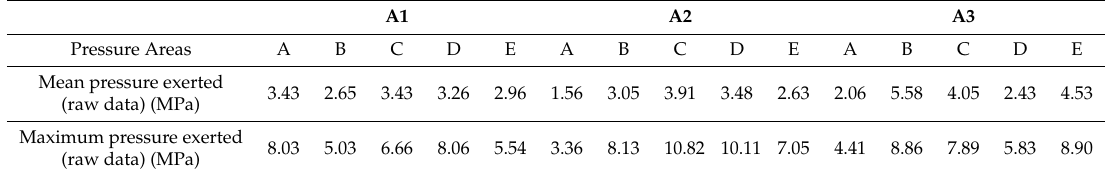
Table 2. Pressure values obtained for the three active aligners (A1, A2 and A3), raw data. A1 A2 A3 Pressure Areas A B C D E A B C D E A B C D E Mean pressure exerted (raw data)